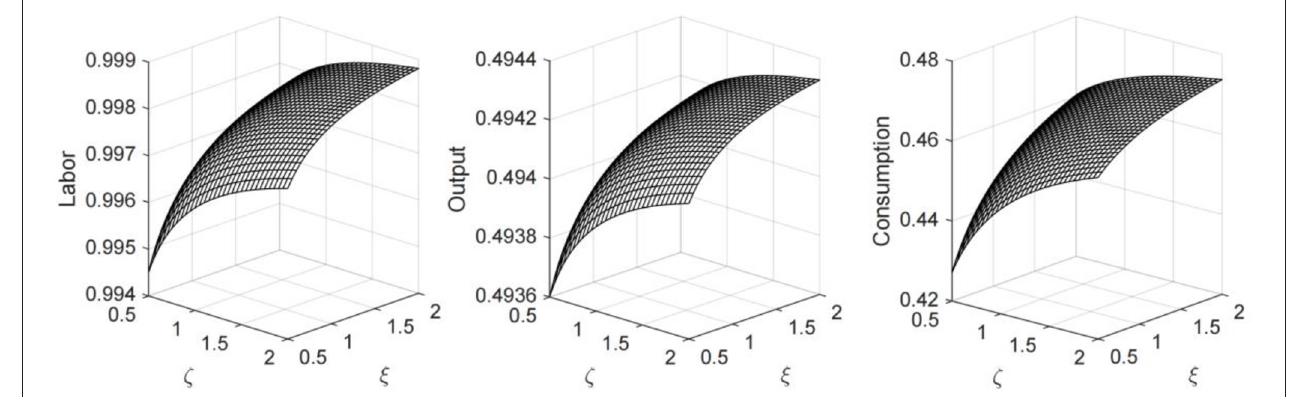
FIGURE 5 | Economic steady states under different combination of ξ and ζ